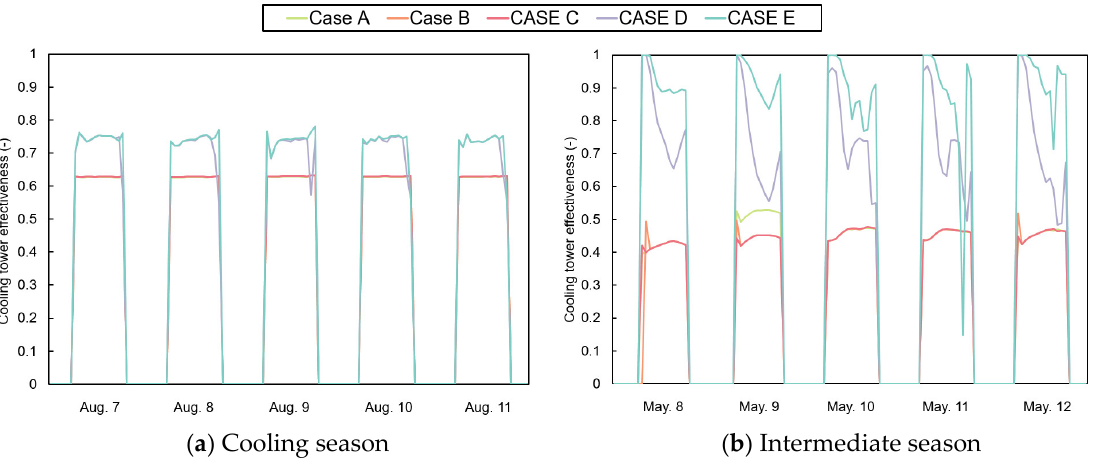
Figure 13. Weekly cooling tower effectiveness for Case A–E.